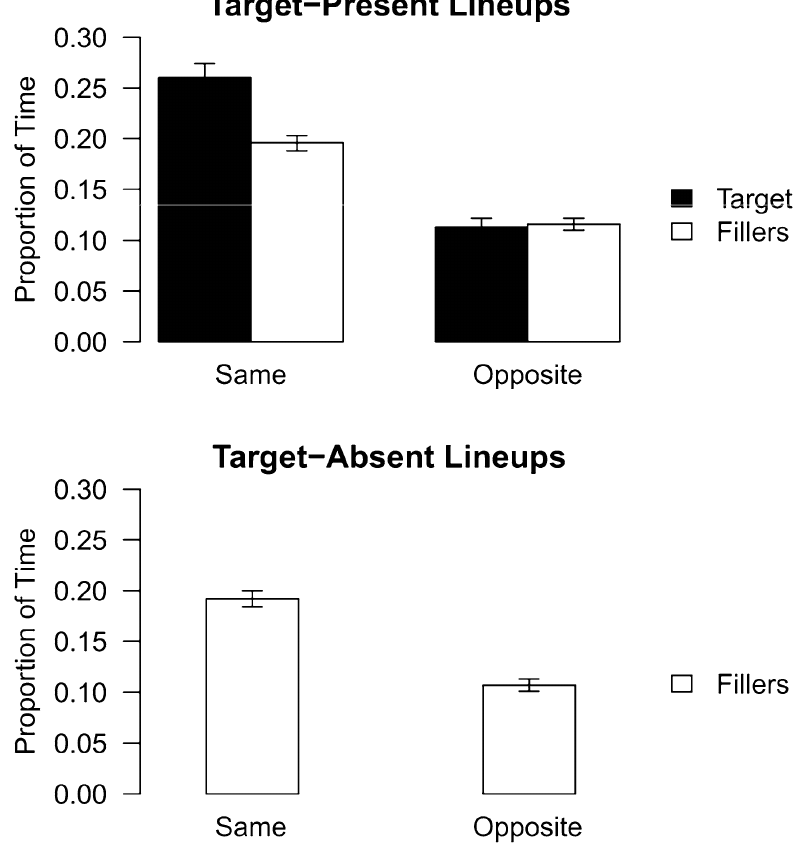
Figure 3. Mean (+ 1SEM) proportion of time participants spent in the target-present and target-absent lineup conditions viewing the perpetrator and filler lineup faces in the same profile compared to the opposite profile as the perpetrator’s face had been shown in the crime